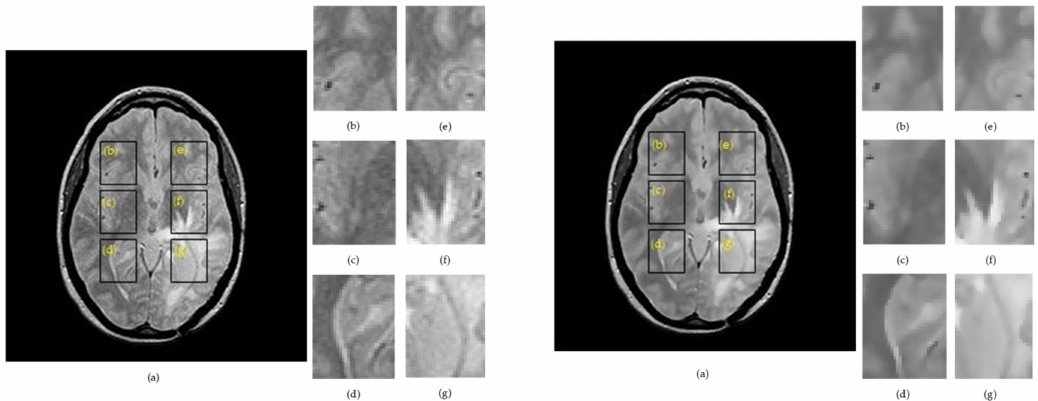
Figure 2. Example of extracting regions of interes ROIs in proton density PD image for a patient with glioma, where: Left side: ( a ) raw image. Right side: ( a ) denoised image. ( b ) ROI 1L; ( c ) ROI 2L; ( d )